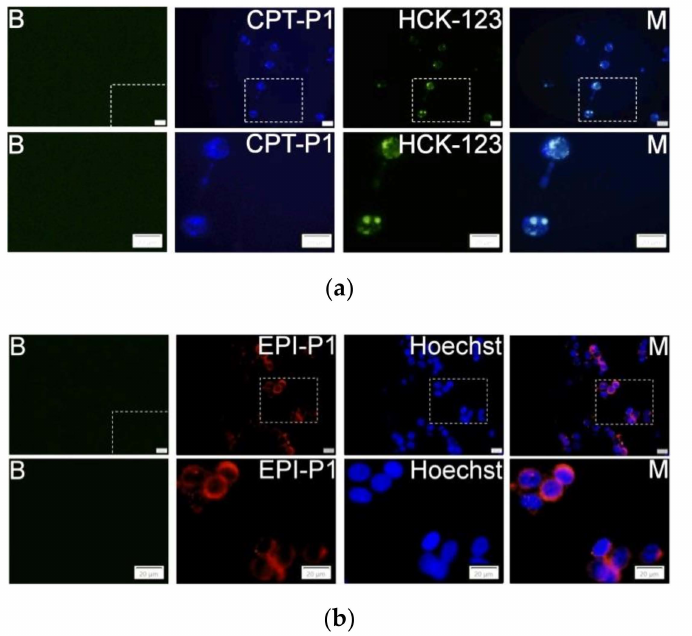
Figure 5. MCF-7 cells fluorescence images and sections of cells without particles and LysoTracker or Hoechst (B). ( a ) Cells with 0.1 mg/mL of CPT-P1 aggregates, 50 nM of LysoTracker Yellow HCK-123 and merged pictures (M); ( b ) Cells with 0.1 mg/mL of EPI-P1 aggregates, 1 µ g/mL of Hoechst